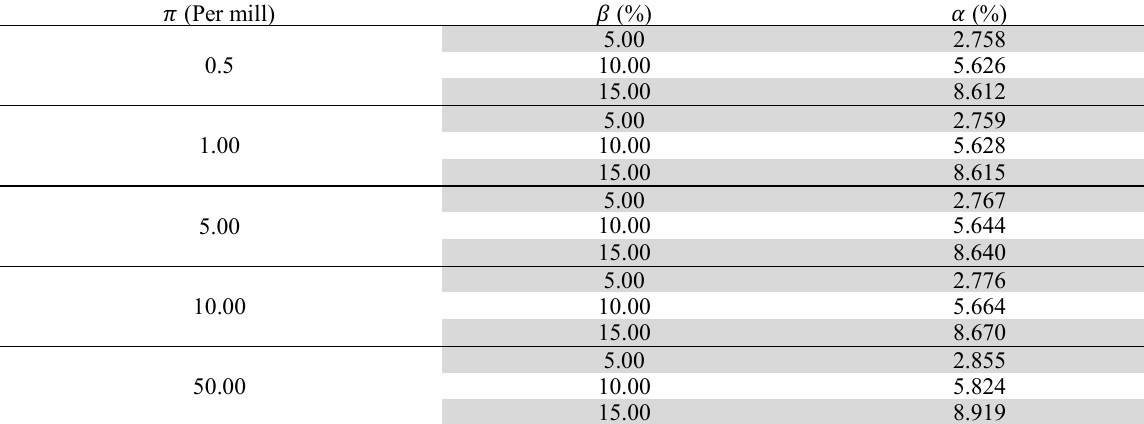
Calculation of α for different values of (cid:2024) and (cid:2010)